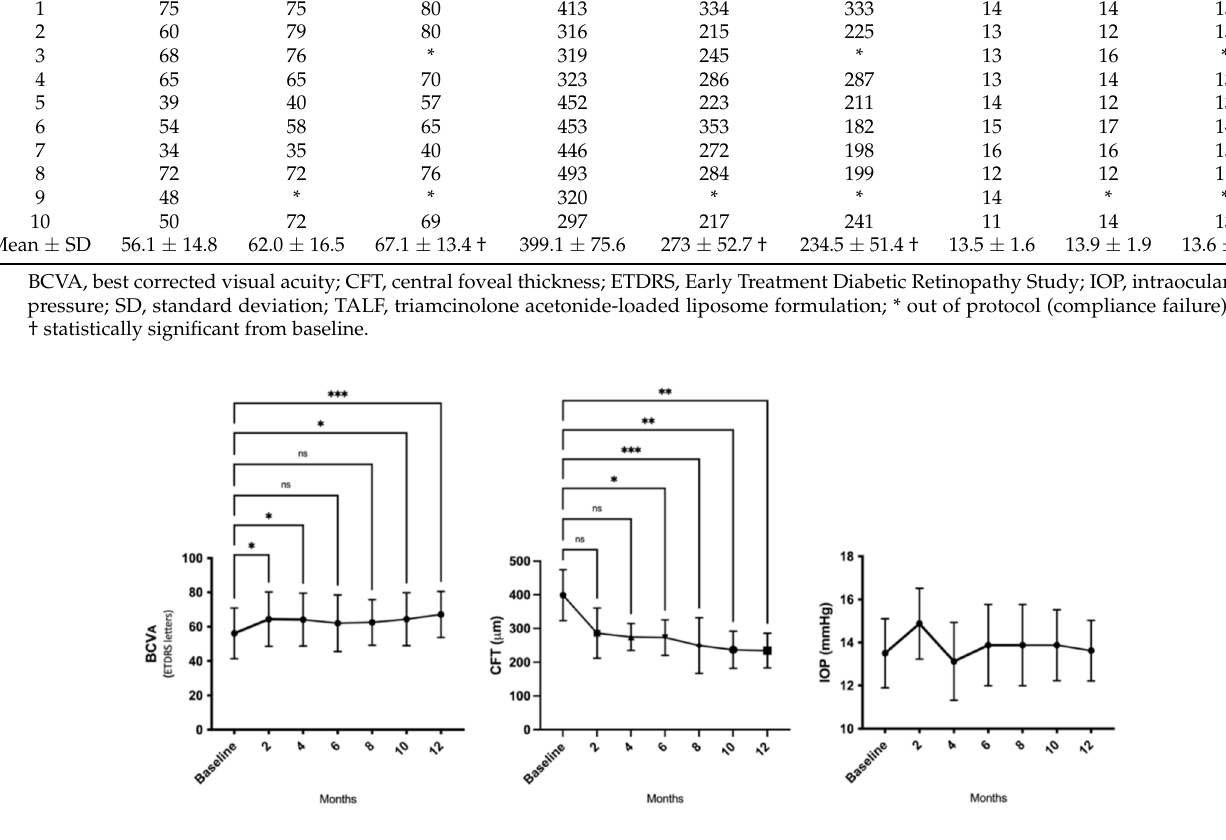
Figure 1. TALF improves BCVA and reduces CFT without IOP rising in patients with nAMD. TALF, triamcinolone acetonide- loaded liposome formulation; nAMD, neovascular age-related macular degeneration; BCVA, best corrected visual acuity; ETDRS, Early Treatment Diabetic Retinopathy Study; CFT, central foveal thickness; IOP, intraocular pressure; * p < 0.05, ** p < 0.01, and *** p <